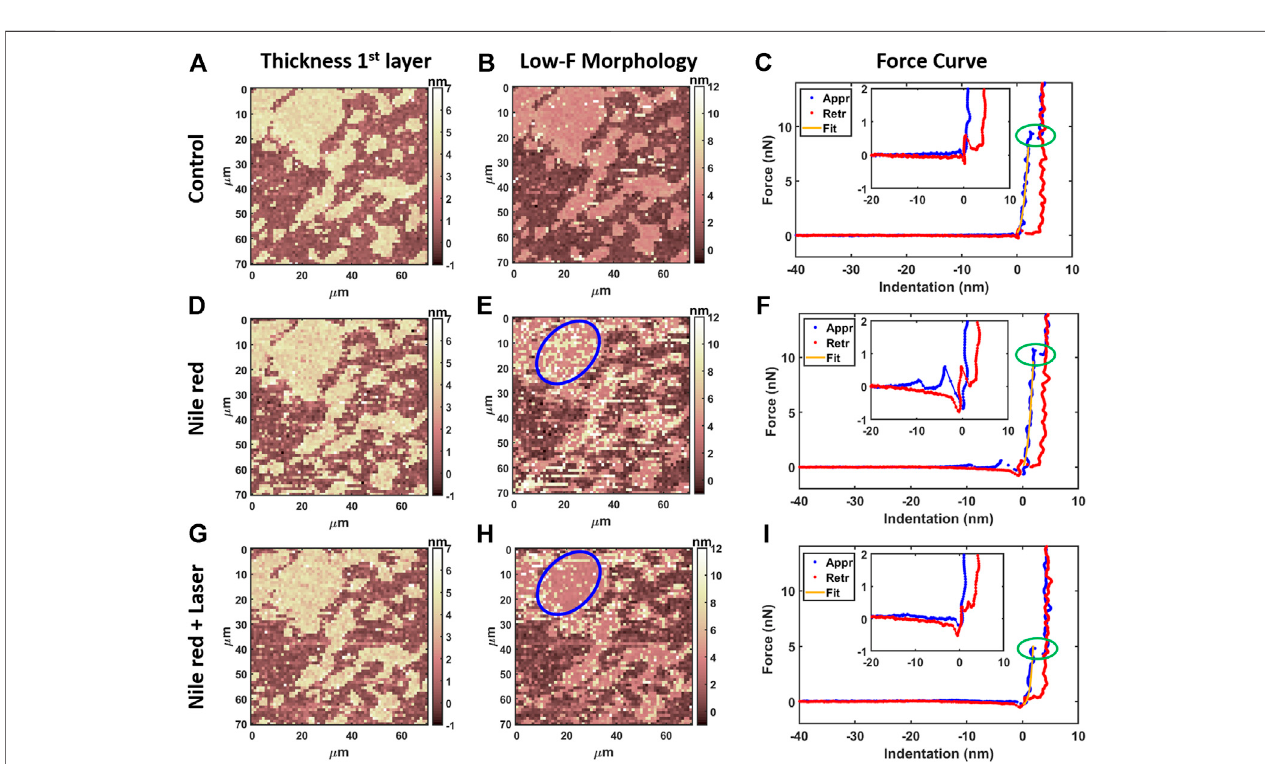
FIGURE 4 | Results of morphological analysis of DOPC partially covering mica using 64x64 force curves. (A) Thickness map of fi rst layer and substrate, (B) low- force (F < 0.3 nN) morphology and (C) examples of approaching (Appr) and retracting (Retr) force curves with fi t from Eq. 1 on control DOPC bilayer. Inset represents a zoom near contact point. With the same order of DOPC control (A – C) , DOPC after 30 min incubation with 2.5 ug/ml Nile red with DMSO at 2.5% (D – F) , and after irradiating probe region with 35.4 mW/ μ m 2 laser (G – I) . Blue circles in panel e and h are representative of an area where overlayer recedes after laser application. Green ovals in panels C , F , i highlight breakthrough events.